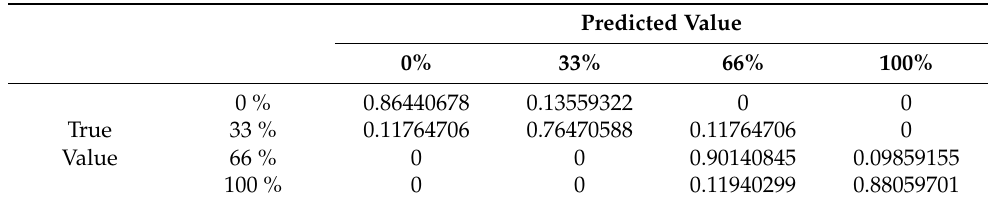
Table 5. Confusion matrix for descriptor 9 with the following features: local binary pattern (LBP), green leaf index (GLI), and hue.